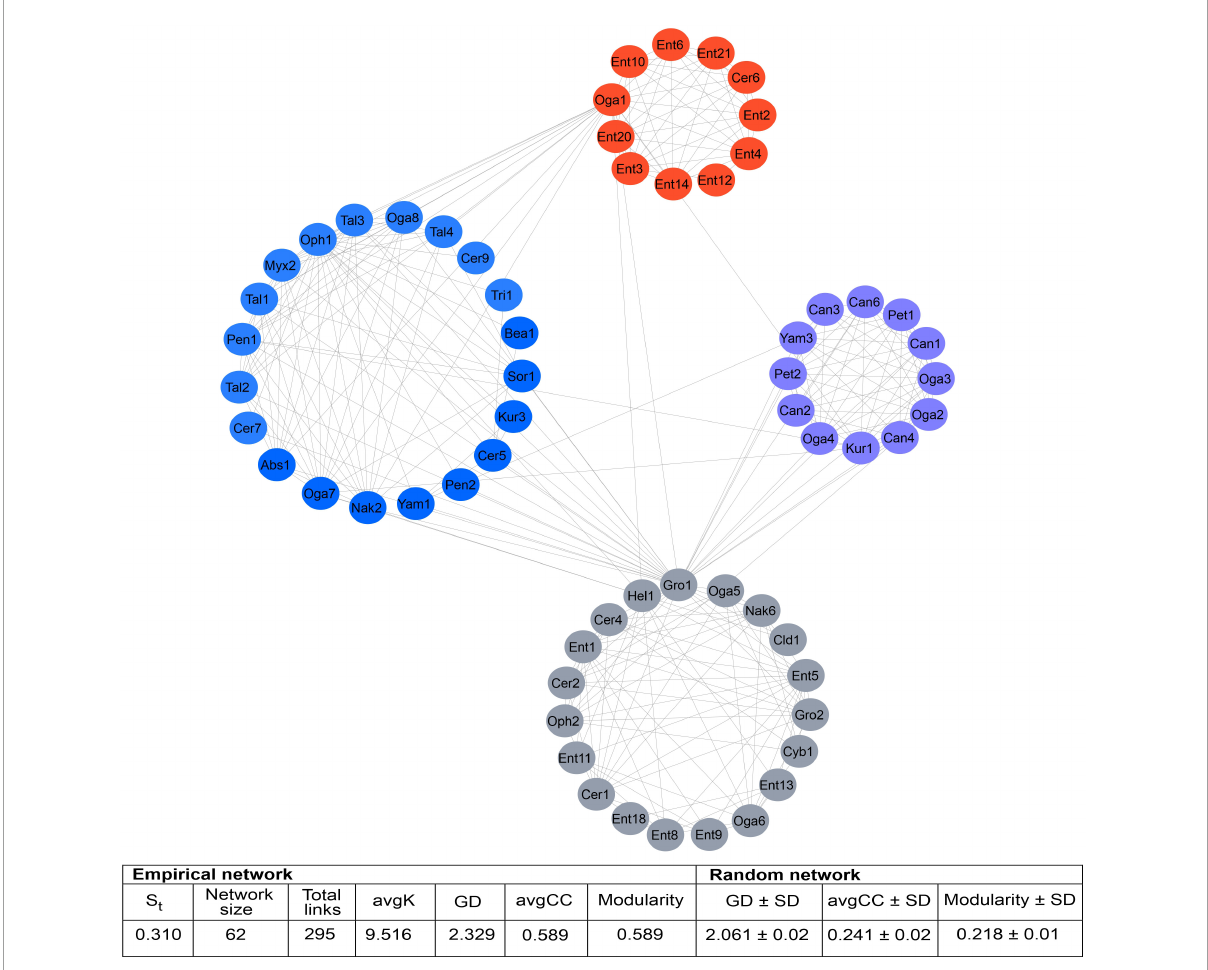
FIGURE4 Global network of the mycetangial fungi assemblages from the species of the D . frontalis complex. It was built with 105 ASVs whose reads > 20 reads, which include to one class, one order,13 genera of filamentous fungi and 9 yeasts. ASVs showed a network contained 62 nodes connected by 295 edges, of which 50.85% were positive connections (mutualistic or commensalistic interactions) and 49.15% negative connections (antagonistic interactions). Four modules integrated the general network. The module 0 included the ASVs from D . mexicanus and D . vitei , the module 1 the ASVs from D . adjunctus , the module 2 the ASVs from D . barberi and D . brevicomis , and the module 3 the ASVs from D . frontalis and D . mesoamericanus . The connectivity distributions in this general network followed the power-law model ( R 2 = 0.013). The values of modularity, average connectivity, average path distance, and average clustering coefficient were significantly higher that of a random network ( p < 0.05) and they are shown in the framework under the figure. Filamentous Fungi: Abs, Absidia ; Bea, Beauveria ; Cer, Ceratocystiopsis; Cld, Cladosporium; Ent, Entomocorticium ; Gro, Grosmannia-Leptographium ; Hel, Helotiales; Myx, Myxotrichum; Oph, Ophiostoma-Sporothrix; Pen, Penicillium; Sor, Sordariomycetes; Tal, Talaromyces; Tri, Trichoderma. Yeast: Can, Candida; Cyb, Cyberlindnera; Kur, Kuraishia; Nak, Nakazawaea; Oga, Ogataea; Pet, Peterozyma ; Yam, Yamadazyma